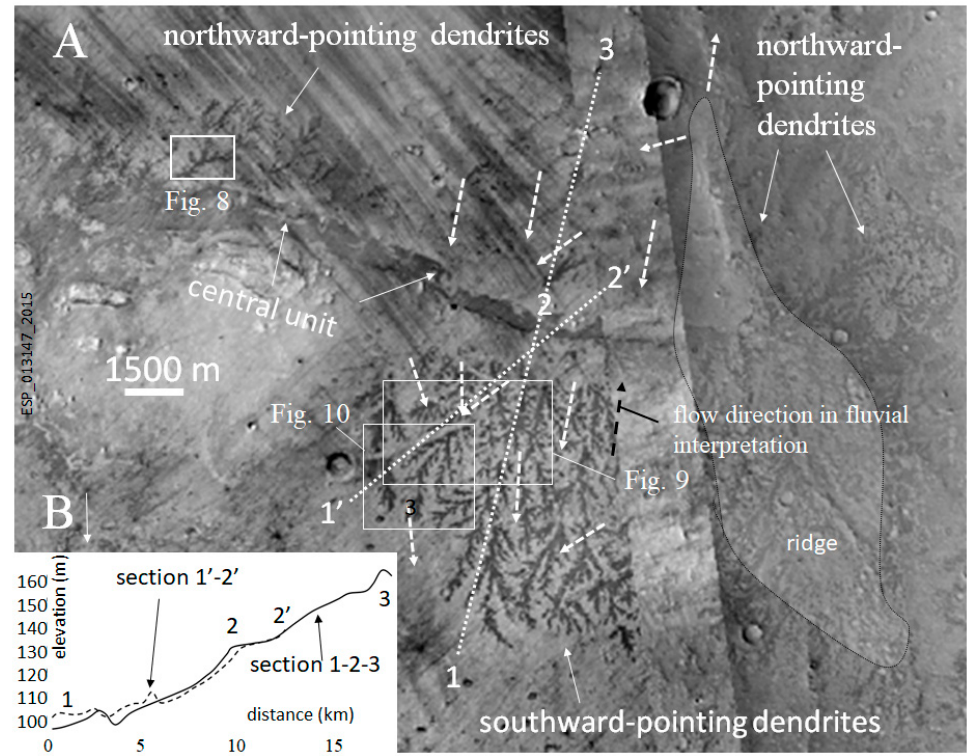
Figure 6. ( A ) Units recognizable in the central Antoniadi dendrites and relative slope gradient. The direction of the slope gradient at the selected locations is indicated with dashed arrows. The white rectangles are further expanded in the following figures. CTX mosaic. ( B ) Transects in MOLA elevation along sections 1–2–3 and 1 ′ –2 ′ drawn in A.